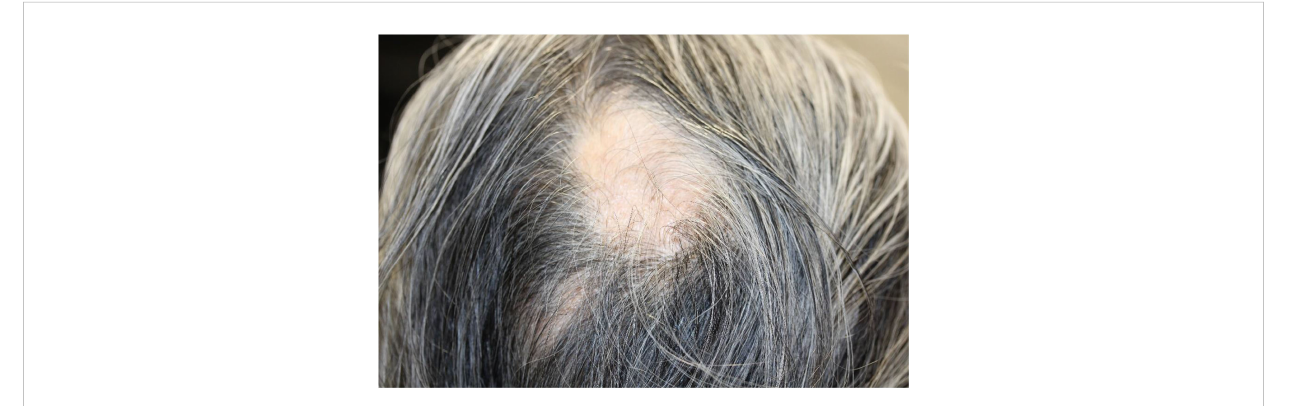
FIGURE 3 Alopecia areata. Circumscribed patches of hair loss on the parietal region. Written informed consent was obtained from the individual(s) for the publication of any identi fi able images or data included in this